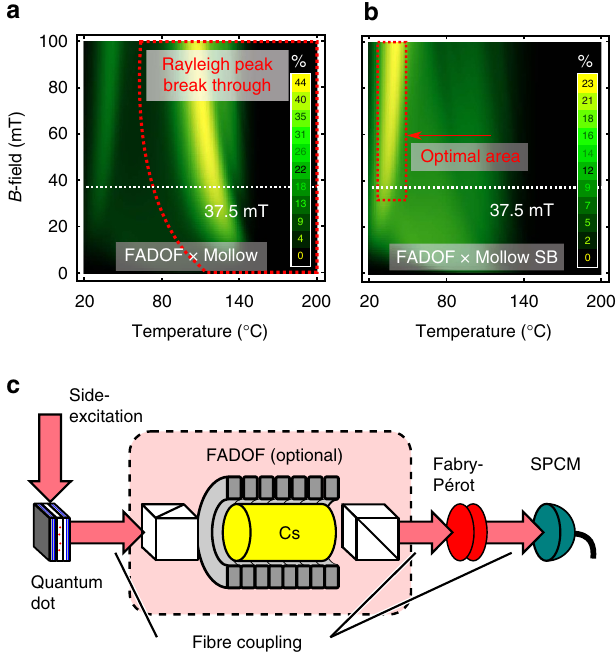
Figure 2 | FADOF optimization and setup for the QD-atom interface description ( a ) Transmission efficiency, Z eff ( B , T ), of the entire Mollow emission filtered by a Cs-Faraday filter. The centre (Rayleigh) peak passes through the filter if the temperature is too high (area to the right of the red dashed line). Experimental configuration, with 37.5mT, is marked (white dashed line). ( b ) Transmission efficiency of the Mollow sidebands, optimal area for best transmission (red highlighted area). It is worth noting that the map in ( a ) is normalized over the total Mollow spectrum (that is Rayleigh line plus the two sidebands), while ( b ) is normalized over the sidebands only (that is over half of the previously used area). This means that the numbers displayed in ( b ) represent the actual value of sidebands transmission. ( c ) Sketch of the complete setup: the light from the resonantly excited QD is sent through the Faraday filter. Because all components are fibre coupled, the FADOF can be easily removed to send the QD light directly into the Fabry-Pe´rot inferferometer. Figure 3 | Mollow triplet sidebands filtered by the FADOF ( a ) Mollow triplet with both sidebands tuned on resonance with the filter transmission features (dotted lines): integration time around 300s. ( b ) Calculated The Mollow triplet obtained by setting the laser at l Mollow triplet (purple) and calculated filter function of the Cs-FADOF ¼ 894.593 nm is displayed in purple in Fig. 3a: it is worth vac (blue): ( c ) Mollow triplet spectrum transmitted through the FADOF: both noting that the F and T sidebands are now matched with the sidebands are simultaneously transmitted while the central Rayleigh peak is known transmission features of the FADOF (central wavelength fully suppressed. Integration time around 4000s. The solid curve is is highlighted by grey dashed lines). Fig. 3b shows the calculated calculated as a simple multiplication of the spectra in ( b ), normalized transmission spectrum of the FADOF and the Mollow triplet considering the current count rate. ( d ) Experiment performed after emission in the present configuration. A simple multiplication of detuning the laser (so also the Mollow triplet) by þ 0.7GHz and with 90% the two spectra gives a representation of the current experiment. of the previous pump power: only one sideband is now transmitted through The deviation between the measured and calculated Mollow the filter. Solid green curve represents the calculation with the actual triplet is the coherent scattering fraction, which forms a narrow- experimental parameters (that is power and detuning) ( e ) Same line at zero detuning. Measuring the spectrum after the filter experiment as in ( c ) but with a laser detuned by (cid:4) 0.8GHz and with same results in the red curve in Fig. 3c. Only the F and T lines are power as in ( d ). For both ( d ) and ( e ) the integration time was around transmitted, being resonant with the Cs-D 1 transition. On the 2000s. The shot noise is displayed by the blue bars on the right side of other hand the central peak, consisting of the Rayleigh line and panels ( c )–( e ). More information can be found in Supplementary residual laser scattering, is shown to be suppressed to background Information. level by more than a factor of 100. This is equivalently shown in the laser-based experiments, depicted in Fig. 1. The calculated suppression exceeds 40 dB over a range of more than 4.1 GHz, assume a reasonable value of 10 5 detectable photons per second essentially centred between the two ground states of caesium. If emitted by the QD. These photons are distributed over the three instead of using the FPI, the atomic-filtered QD light is sent transitions (1/2 on the Rayleigh line, 1/4 per sideband). directly to the SPCM, we obtain for both sidebands 2,000 cps Subsequently, the overall transmission is expected to be (counts per second). Considering the observed intensity on the between 10 and 15% of the integrated sidebands with 6,000 cps two sidebands in comparison with previous studies 20 , we now NATURE COMMUNICATIONS|7:13632|DOI: